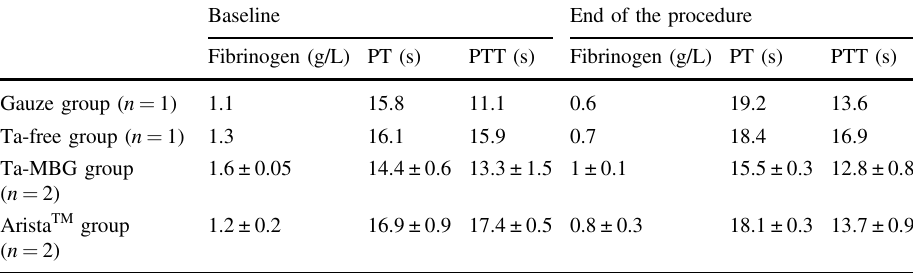
Table 2 Coagulation pro fi le (time ± standard error of